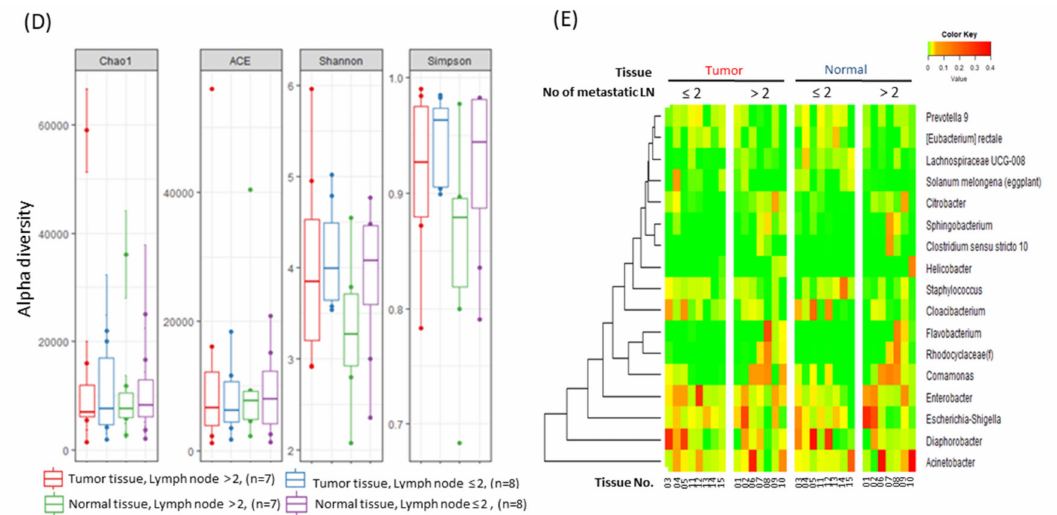
Figure 2. Comparative analysis of the extracellular vesicle (EV)-derived microbiomes according to pathologic findings: ( A ) comparison of alpha diversity indices between tumor and normal tissues according to tumor size, ( B ) clustering of common microbiota in paired normal and tumor tissues according to tumor size, ( C ) specific microbiota taxa with increased abundance in normal and tumor tissues according to tumor size (mean ± SEM, * p < 0.05), ( D ) comparison of alpha diversity indices between tumor and normal tissues according to the number of metastatic lymph nodes, ( E ) clustering of common microbiota in paired normal and tumor tissues according to the number of metastatic lymph nodes, and ( F ) Specific microbiota taxa with increased abundance in normal and tumor tissues according to the number of metastatic lymph nodes (mean ± SEM, * p < 0.05).